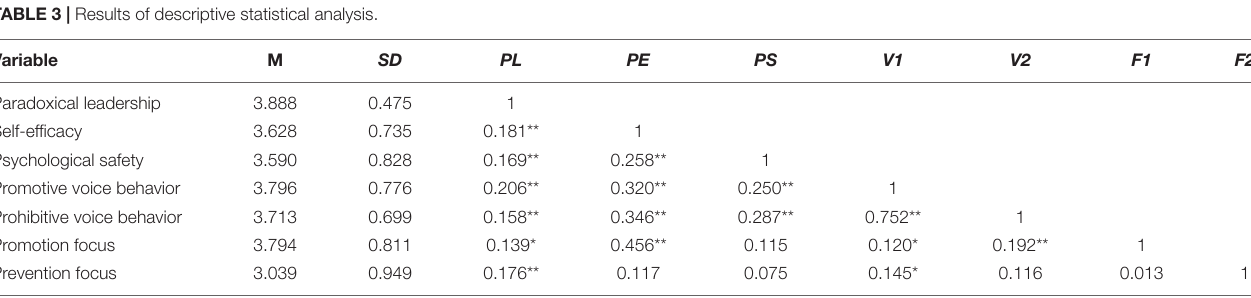
TABLE 3 | Results of descriptive statistical